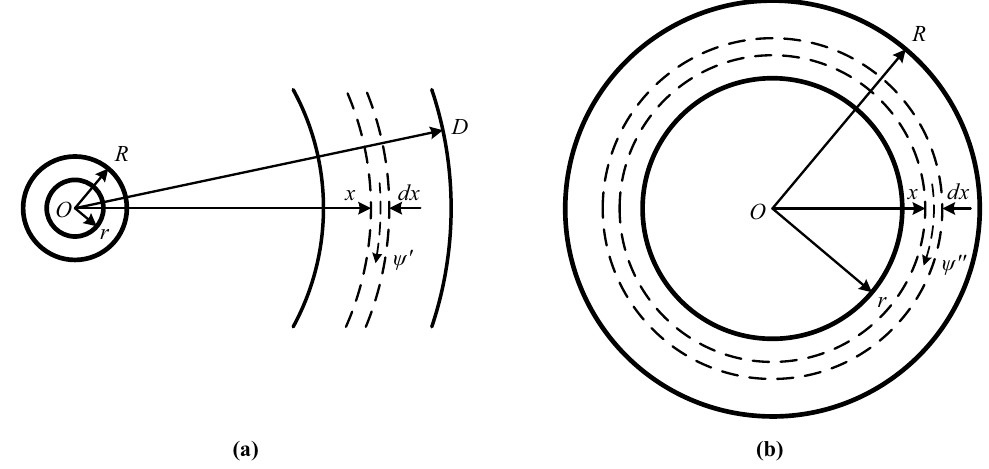
Figure 1. The distribution of magnetic fields of a tubular conductor: (a) external; (b)